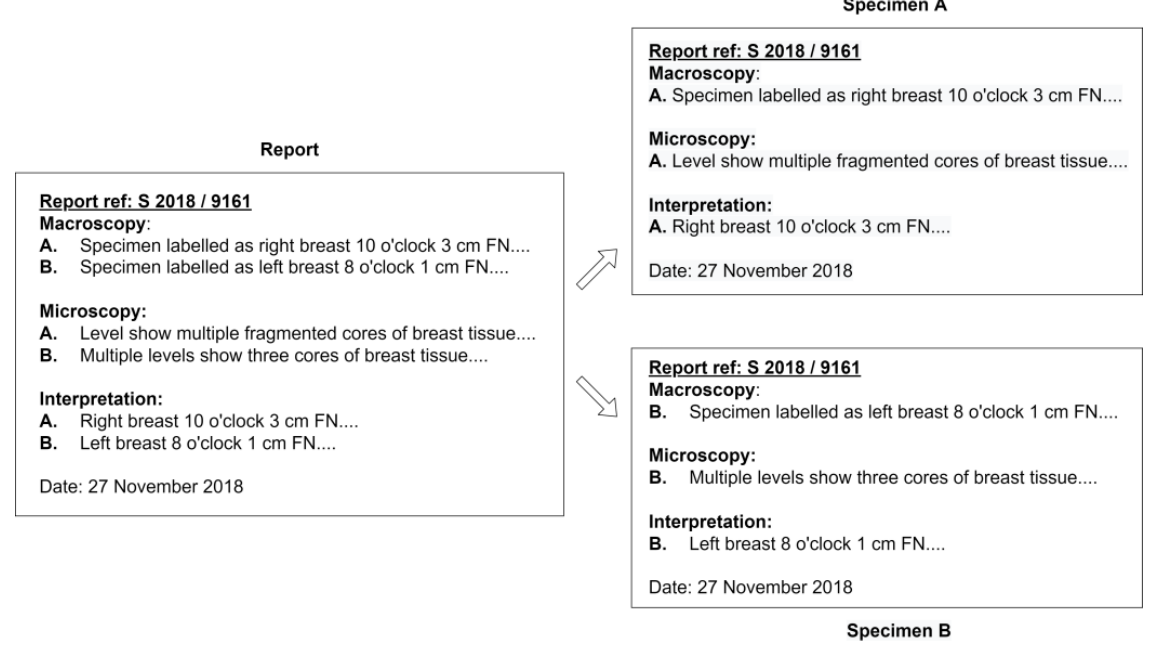
Figure 3. Input for the NLP algorithm.